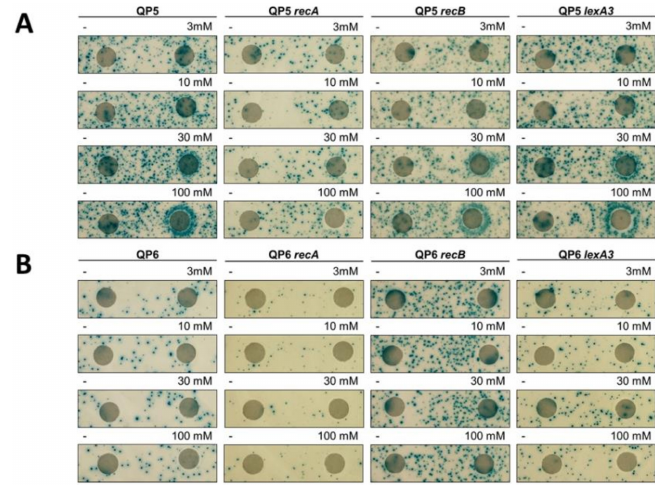
Figure 8. Mutator effect of formaldehyde. Disk diffusion assay for Lac reversion using QP5 ( A ) and QP6 ( B ) reporters ± recA , recB , lexA3 and lactose X-gal papillation medium. Each disk on the right was saturated with 5 µ L of Formaldehyde at the indicated concentrations. The control disk on the left was spotted with 5 µ L of